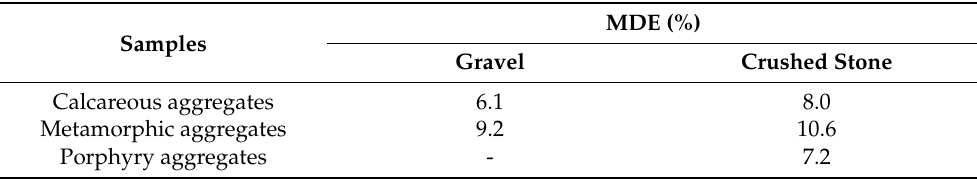
Table 12. Wear-resistance coefficient for Micro-Deval (MDE, expressed in percentage) of the aggre- gates analyzed [23].